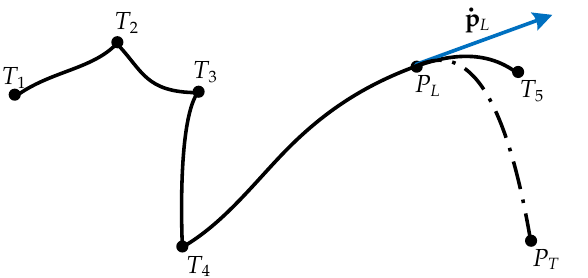
Figure 2. Schematic of a point-to-point motion where the CSPR has to pass through a number of target points T i , which may also be outside the SEW, and launch an object towards a target point P T